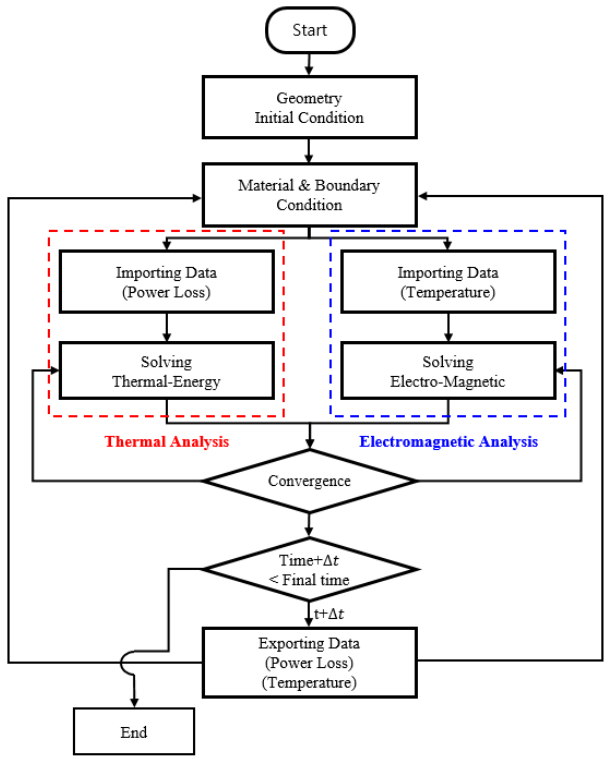
Figure 1. Numerical analysis procedure of induction heating.